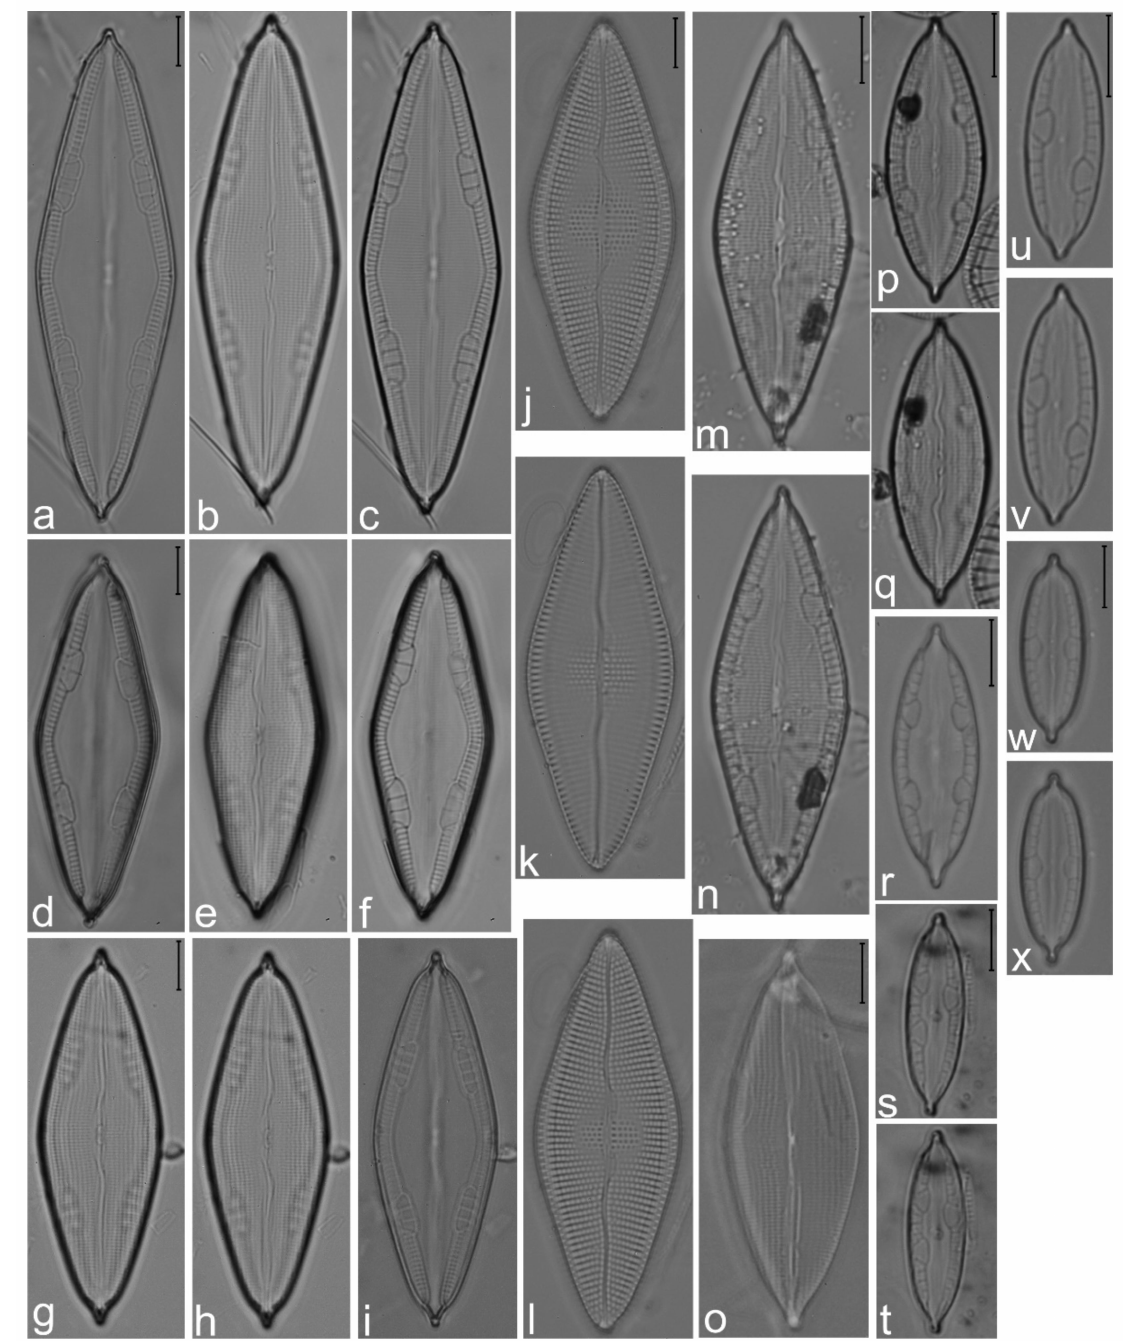
Figure 21. ( a – i , m – r ) Mastogloia erythraea var. erythraea in different focal planes; ( j – l ) M . rhombica ; ( s – v ) M . erythraea var. grunowii in different focal planes and showing a range in size; ( w , x ) M . biocellata . Scale bar = 10 µ